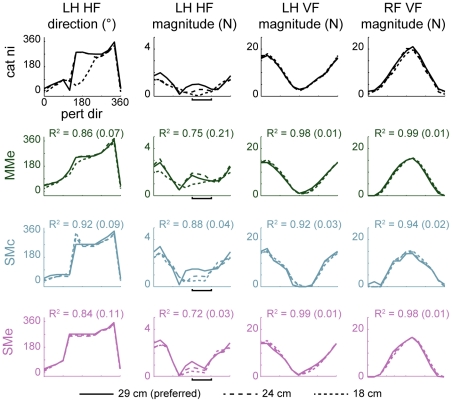
Comparison of limb forces predicted by controlling experimentally-derived muscle synergies rather than individual muscles in polar coordinates.Data correspond to horizontal-plane forces shown in Figure 6. Colors as in Figure 6. Note that LH HF magnitudes in perturbation directions that unloaded the left hindlimb (horizontal bars, 180° to 270°) exhibited a monotonic decrease in models SMc and SMe from the preferred (29 cm, solid lines) to the shortest (18 cm, shortest dashed lines) stance distance similar to data that was not predicted in MMe.